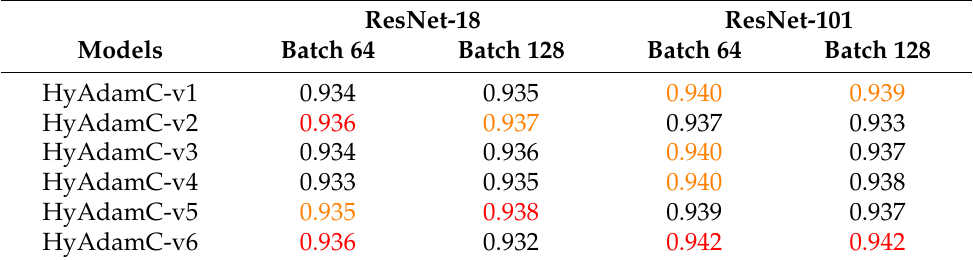
Table 4. The test accuracies of the ResNet-18 and 101 trained by the six HyAdamC models. The first and second best results are highlighted in red and orange, respectively.